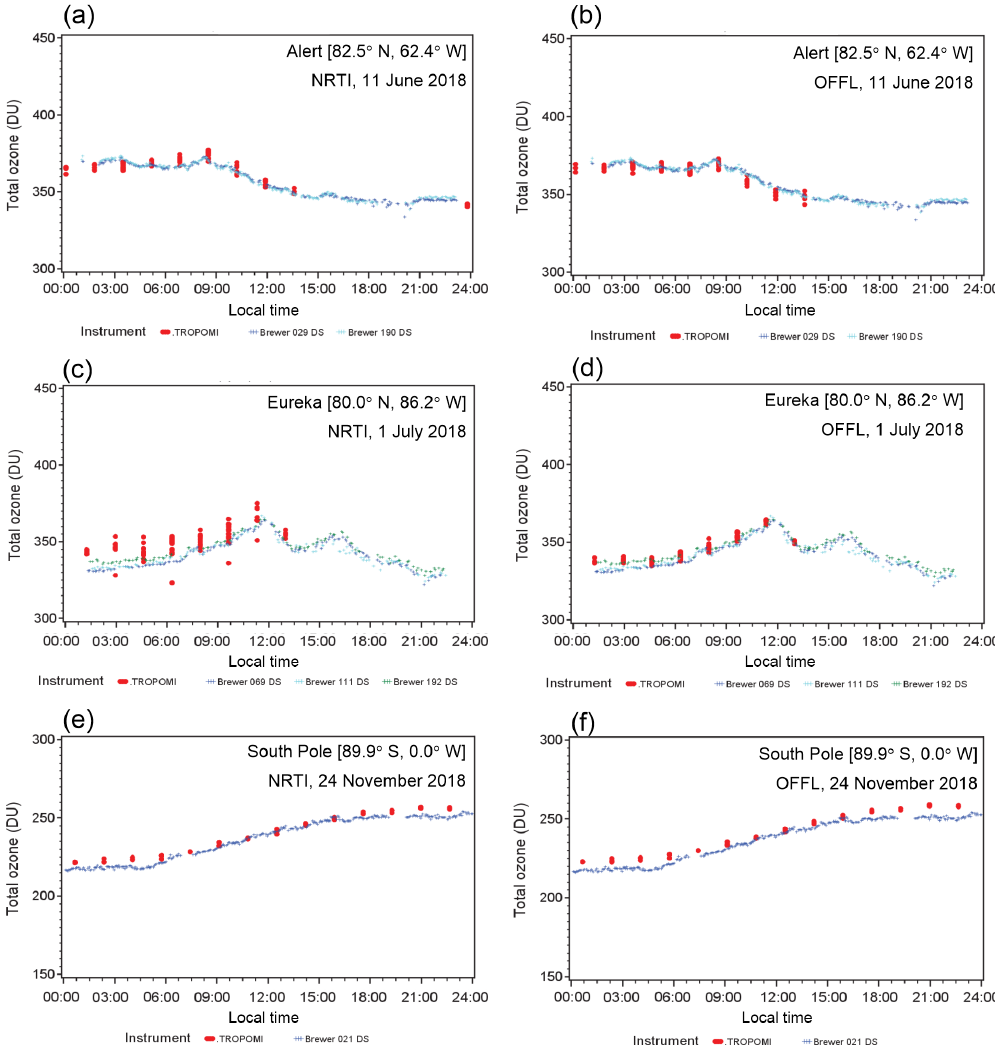
Figure 9. The diurnal variation in the TOC (in DU) measured by TROPOMI (a, c, e) NRTI product and (b, d, f) OFFL product and Brewer spectrophotometers at three high-latitude northern and southern stations that are part of the Canadian Brewer Network. The maximum distance for the co-locations is